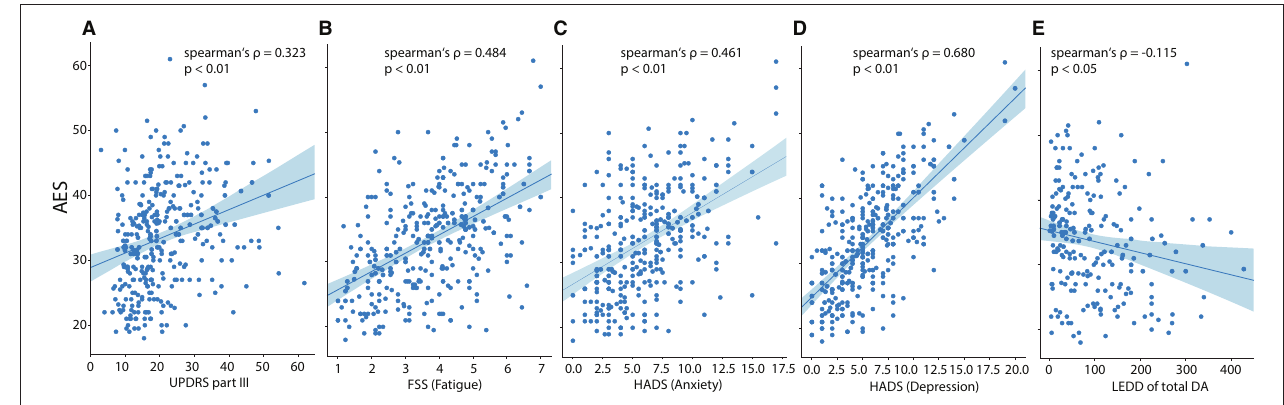
FIGURE 2 | Scatterplots for apathy (AES total score) vs. (A) motor impairment (UPDRS-III), (B) fatigue (FSS), (C) anxiety (HADS), (D) depression (HADS) and (E) LEDD of total dopamine agonists. The regression lines are presented together with Spearman’s correlation coefficient ( ρ and the associated p -value).